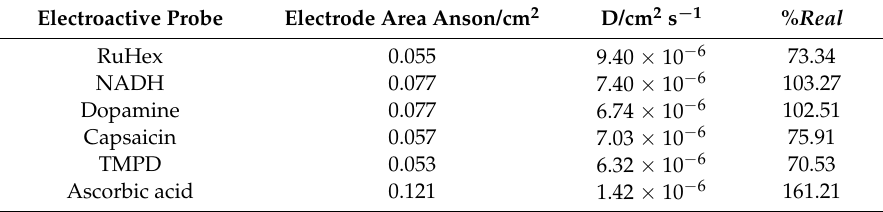
Figure S1: Topography measurement on a screen-printed electrode (A), height profile (B) from data shown in A and a 3D plot of the topography measurements